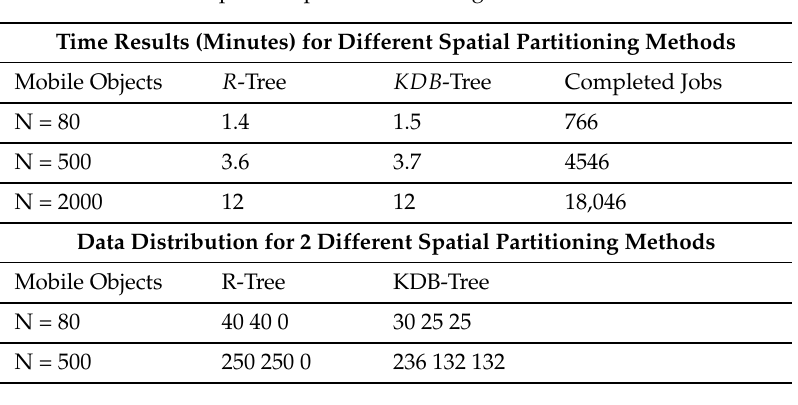
Table 10. Impact of Spatial Partitioning in Time Performance.